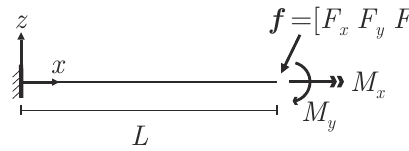
Figure 5. Cantilever beam with tip force and moment resultants.